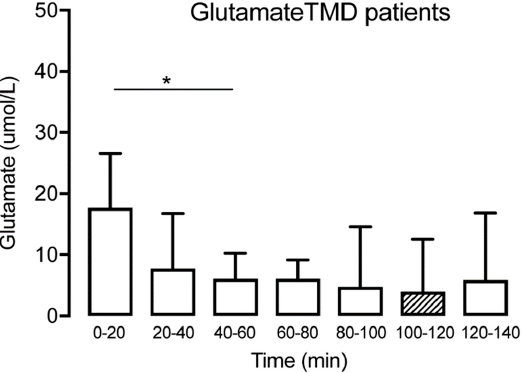
Figure 5. Interstitial glutamate at different time points for the TMD group ( n = 15) showing a significant decrease until T40–60, followed by a stabilization. The hatched box indicates time point T100–120, often used as a baseline. * indicates p < 0.05.